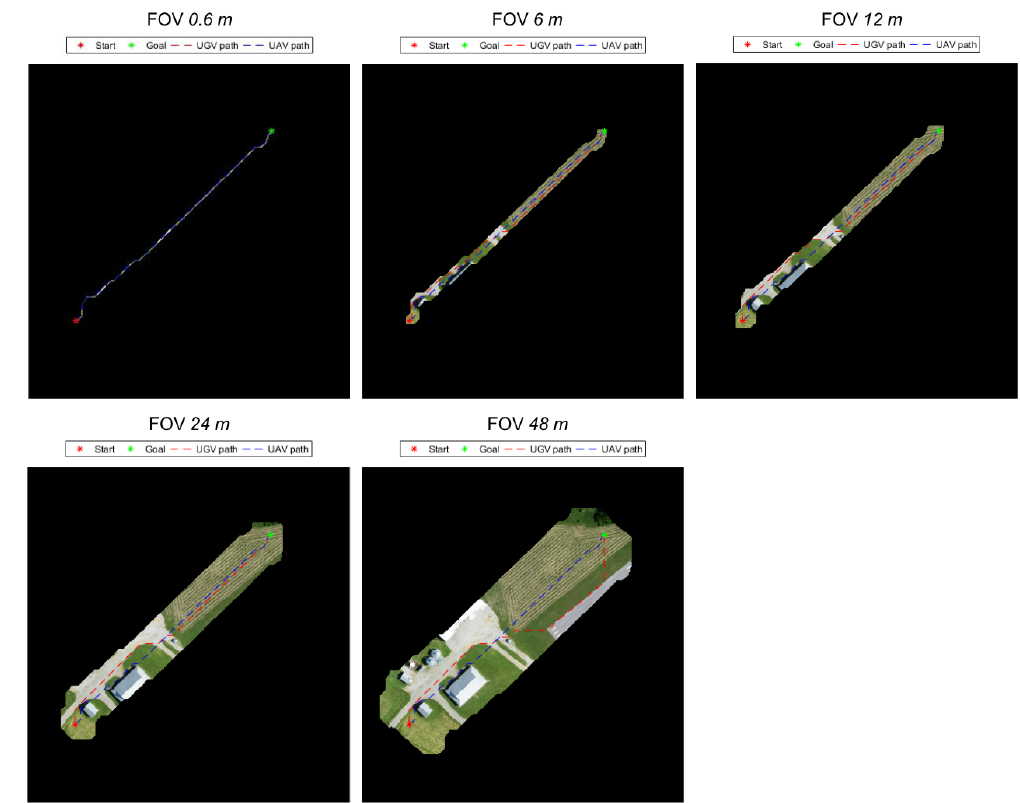
Figure 8. Paths corresponding to cases presented in Table 1. As the field of view of the simulated camera is expanded, the path cost is reduced despite an increase in distance